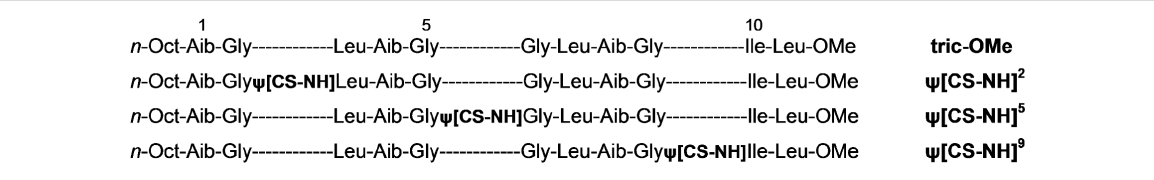
Figure 1: List of primary structures and abbreviations for the peptides studied in this work. The [Leu 11 -OMe] trichogin GA IV is termed tric-OMe and its thionated derivatives at position 2, position 5, and position 9 are termed ψ [CS-NH] 2 , ψ [CS-NH] 5 , and ψ [CS-NH] 9 , respectively.